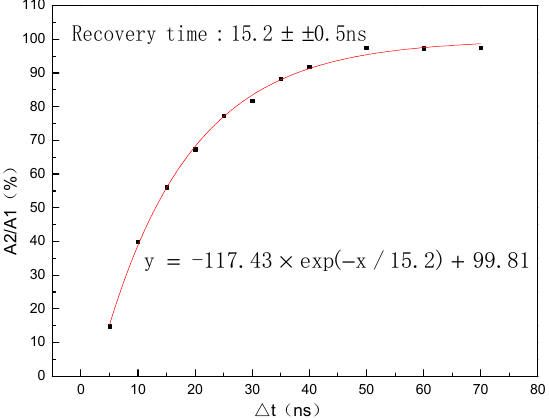
Figure 5. The overall recovery time of 1.4 × 1.4 mm 2 EQR SiPM is 15.24 ± 0.5 ns while total about 20,000 pixels was fired, it measured with double light pulse method.